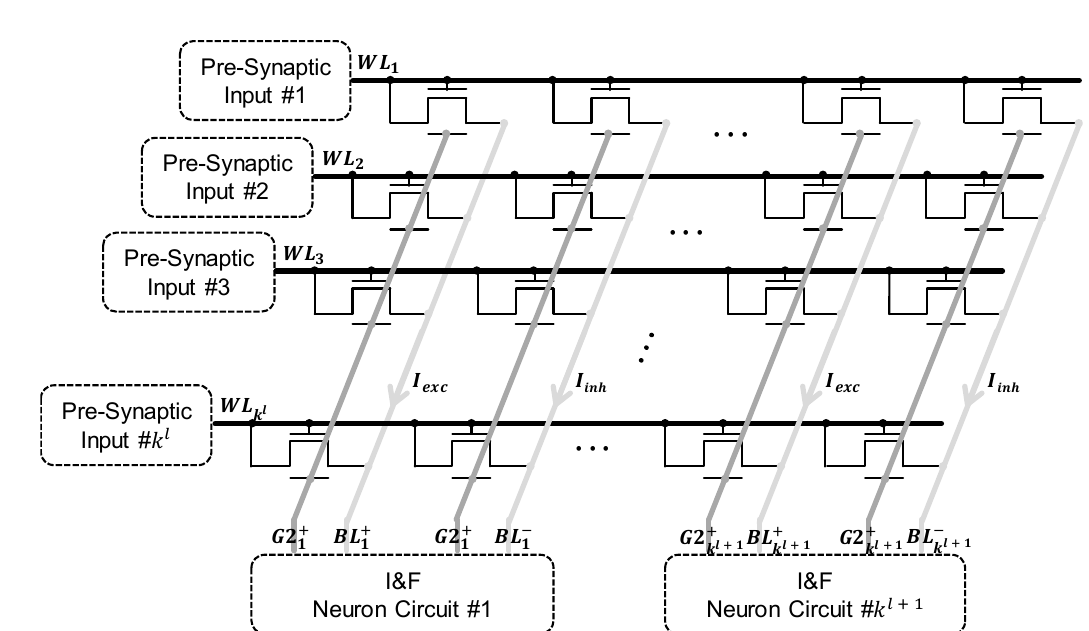
Figure 4. Schematic view of the hardware-based SNN. Pre-synaptic inputs are applied to wordlines (WLs), and the current summation is performed in bitlines (BLs). Two BLs are paired for the excitatory and inhibitory synaptic currents. Gate 2 of the synaptic devices are connected in BL direction by G 2 +